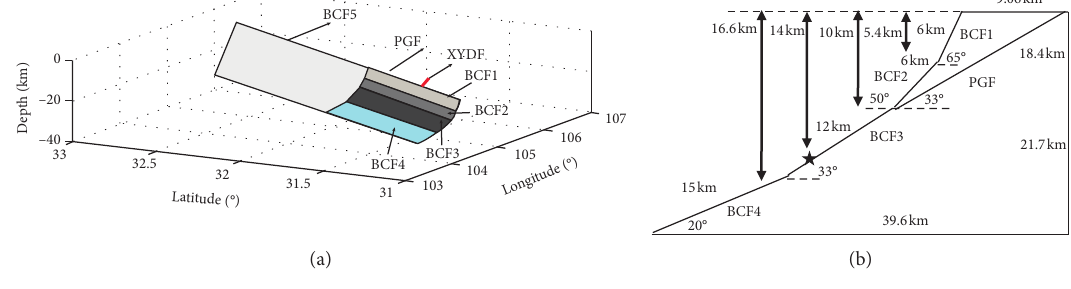
Figure 4: The 3D fault model (a) and model section (b).